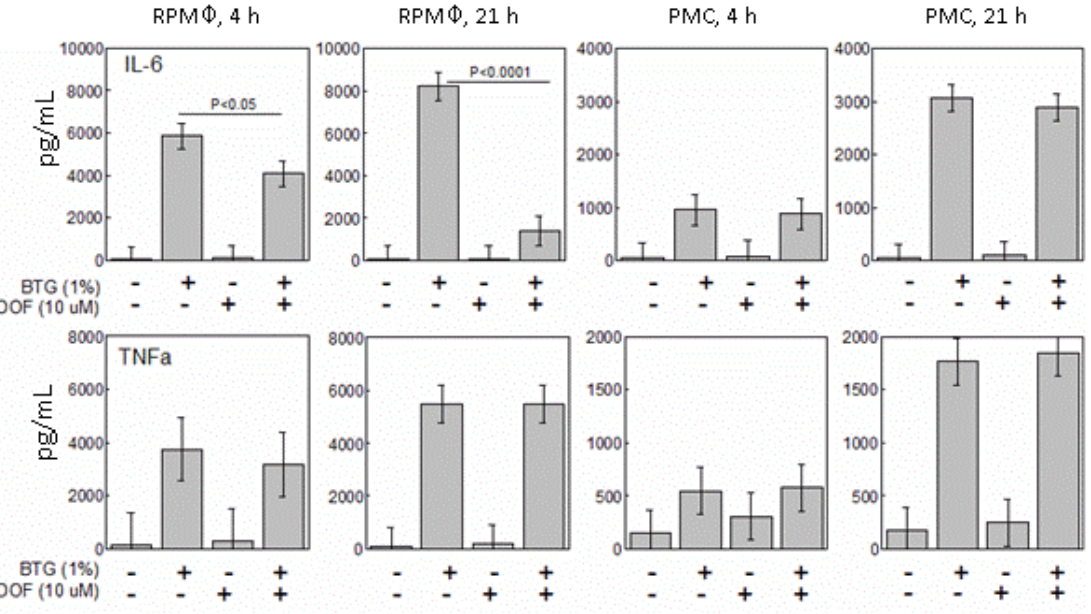
FIGURE 3. Effect of DOF on IL-6 and TNFα secretion by murine RPMΦ and peritoneal mesothelial cells (PMC) cultured in vitro . Supernatants were collected from RPMΦ and PMC cells exposed to either 1% BTG and/or DOF (10 μM) for either 4 or 21 h. Levels of IL-6 (top row) and TNFα (bottom row) were determined by FACSArray bioanalyzer using a murine inflammation CBA kit. Data represent the mean ± 95% CI of five independent experiments, each performed in